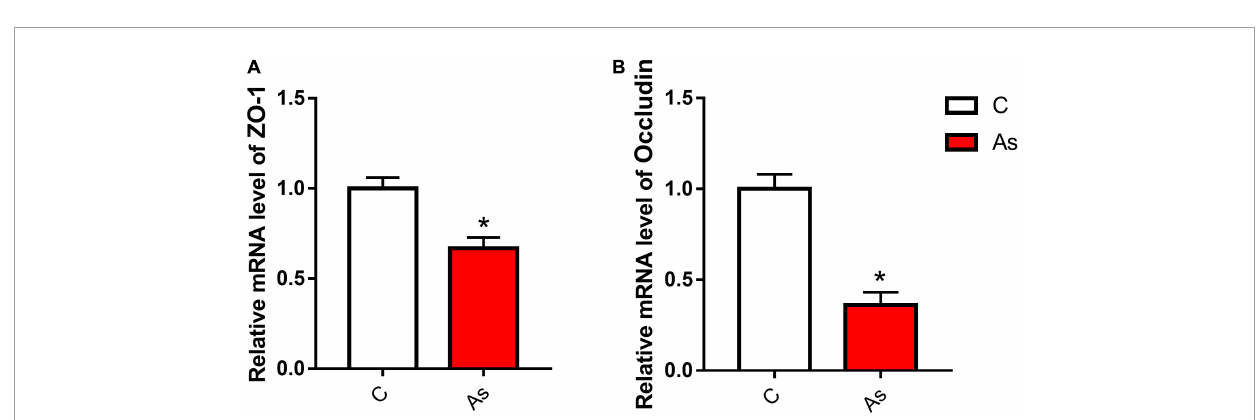
FIGURE3 Effect of arsenic (As) exposure on zonula occludens (ZO-1) (A) and occludin (B) expression. The data are presented as the means ± standard deviations of three parallel measurements. * P < 0.05 indicates a significant difference between the two groups.